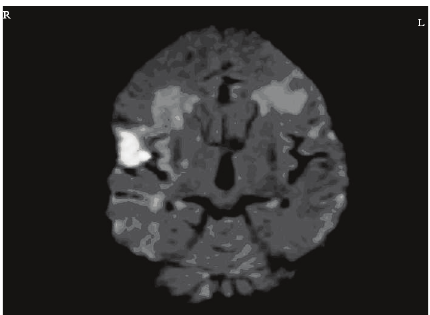
Figure 1: Diffusion-weighted magnetic resonance imaging demon- stratesrightfrontalopercularrestricteddiffusionwhichisdiagnosed as acute opercular infarct (R: Right, L: Left).